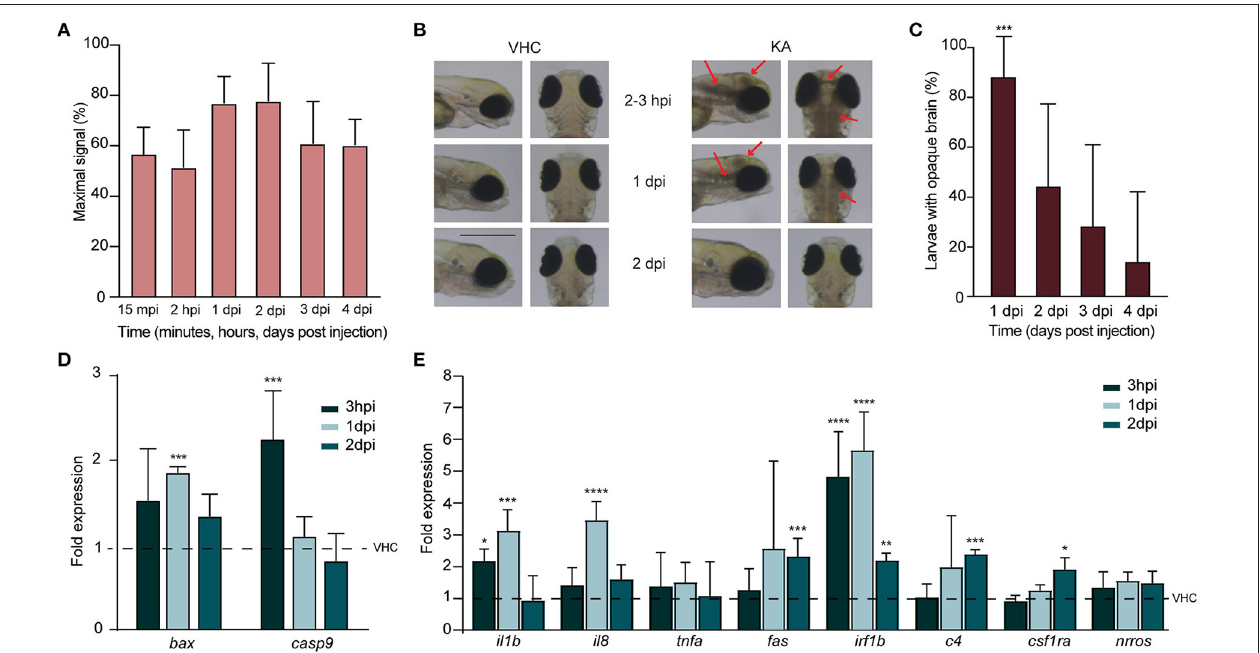
FIGURE 2 | Injection of kainic acid in zebrafish larvae results in acute brain inflammation and apoptosis. (A) LC-MS/MS analysis of kainic acid (KA) levels in larval heads after injection of KA after 15min post injection (mpi), 2h post injection (hpi) and 1–4 days post injection (dpi) demonstrating stable levels of KA in zebrafish head tissues during each experimental timepoint. Maximal signal (%) refers to the highest signal found among measured samples. Data from four independent experiments are presented as mean ± s.d. (B) Representative images of VHC- and KA-injected larvae at 2–3 hpi upon 2 dpi. Characteristic opaque brain tissue was noticeable after 2–3 hpi and persisted mainly until 1 dpi. Red arrows mark the brain lesions. Scale bar 500 µ m. (C) Quantification of larvae (%) with opaque brain at 1–4 dpi. All KA-injected larvae displayed opaque brain after 2–3 hpi (data not shown) and after 24h still > 80% of the larvae (*** p < 0.001 compared to VHC